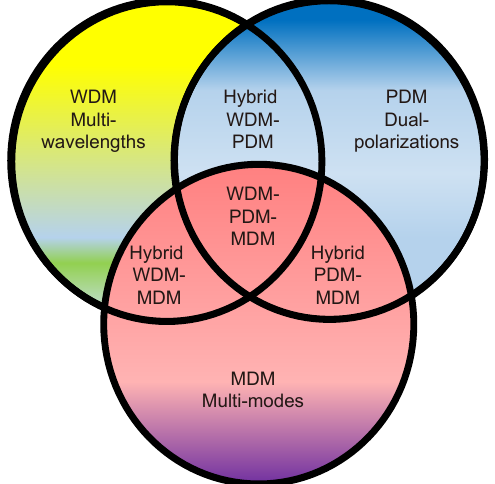
Fig. 13 | Hybrid MUX/DEMUX techniques combing multiple indi- vidual